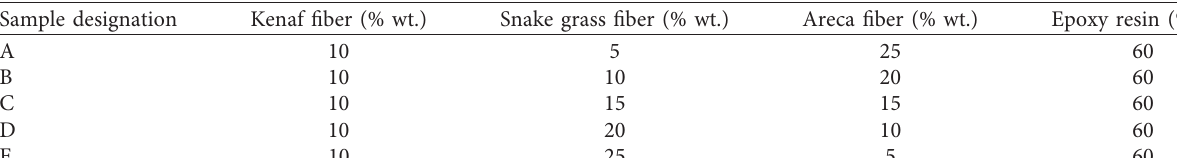
Table 2: Designation of hybrid composites.